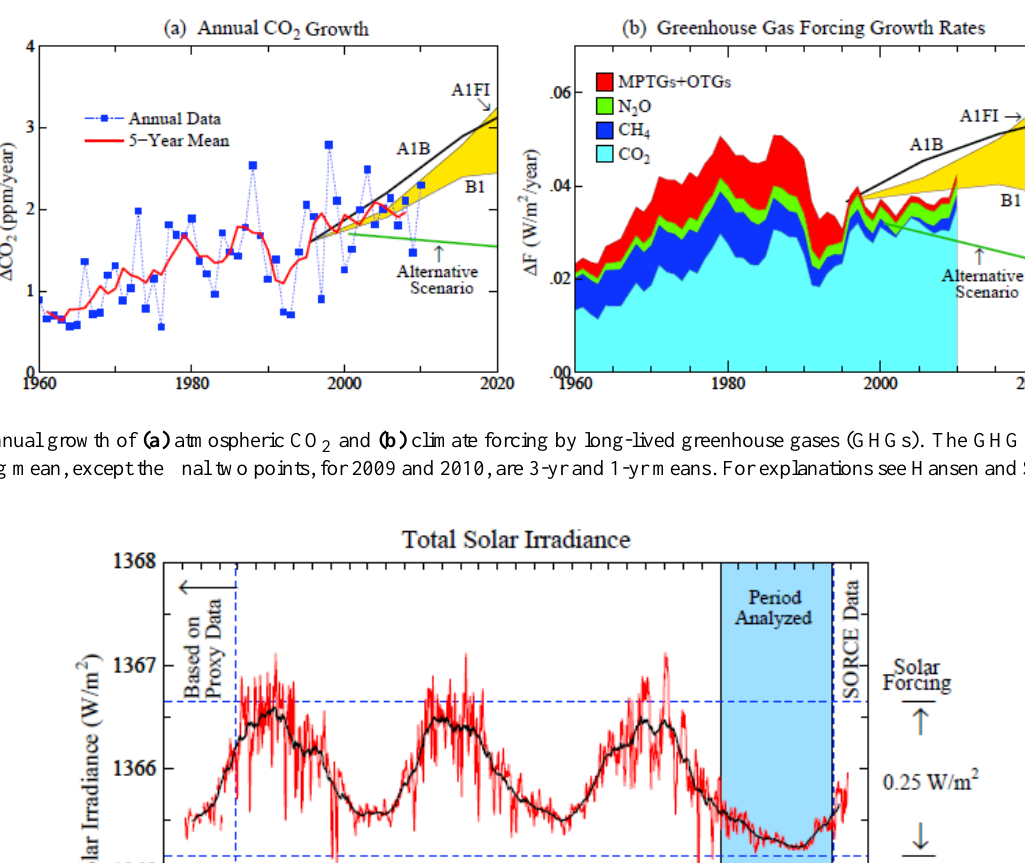
Fig. 15. Schematic diagram of Earth's energy imbalance (above) from Trenberth and Fasullo (2010) and (below) as calculated in this study. Our calculated imbalance, the top edge of the red area, is the moving 6-year trend of the calculated planetary energy imbalance for the intermediate response function. The red area is energy uptake by melting ice and warming ground and air. Measured ocean is 6-year trends of Argo analyses (see text) plus two small deep ocean terms from Purkey and Johnson (2010). Although the